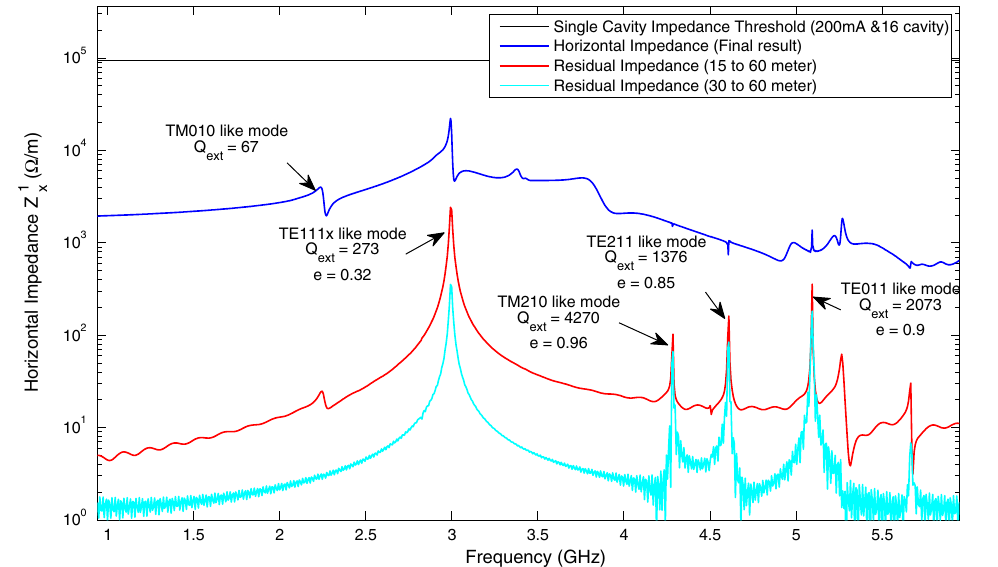
FIG. 12. Single-cavity horizontal wake impedance Z 1 (cyan curve) are compared. The blue curve is the fully resolved impedance based on the calculated Q